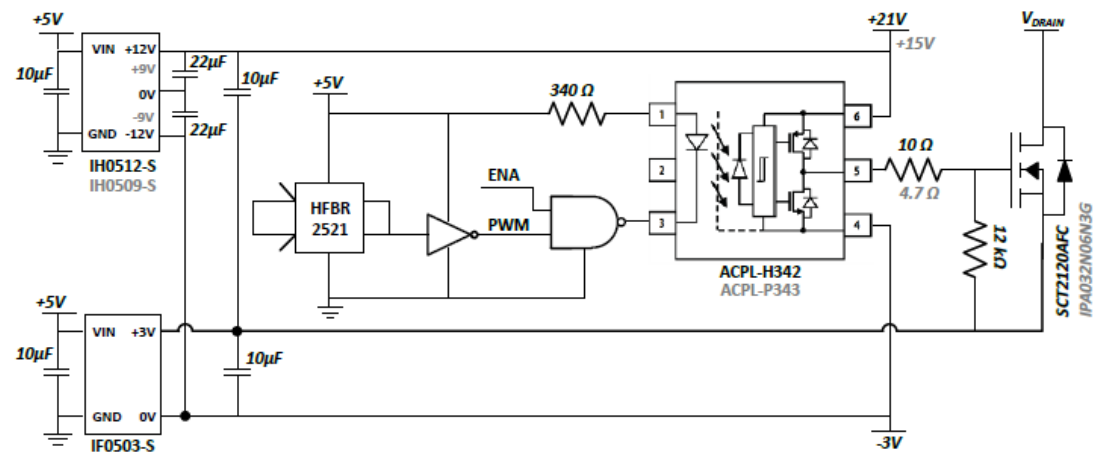
Figure 3. Schematic of gate driver circuit, featuring a unified design for both primary and secondary side transistors.